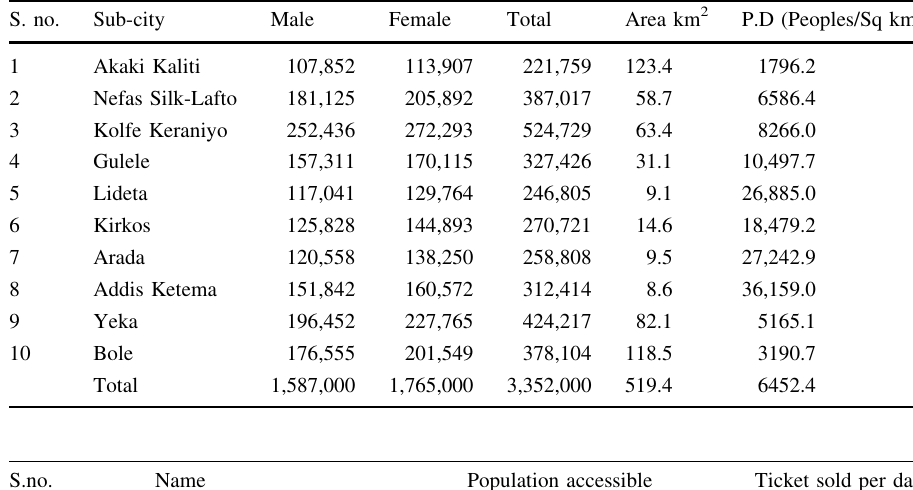
Table 5 Total number of population accessible of LRT system within the 2000-m walking